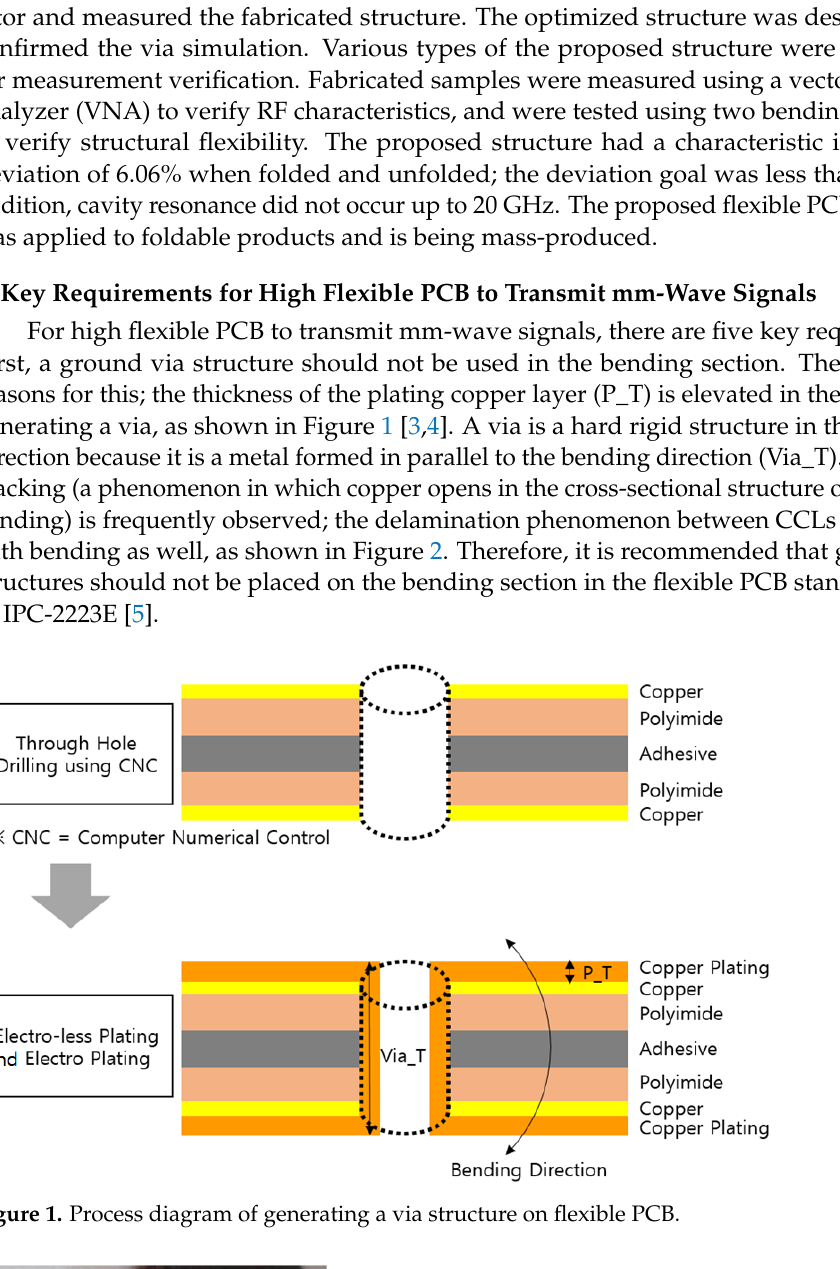
( c ) Figure 4. Return current densities of outer copper. ( a ) Current density without outer copper crack; ( b ) Current density with 1 um outer copper crack and an attached anisotropic conductive adhesive; and ( c ) Current density with 1 um outer copper crack and an attached isotropic conductive adhesive. Fourth, the impedance deviation before and after bending should be less than 10%. Figure 5 presents a conceptual diagram of signal transmission and reflection in the case of impedance discontinuity. The value of Z 0 is 50 ohm, which is mm-wave RF target imped- ance. As the impedance of the bending section, Z l , deviated from 50 ohm, the reflected wave (Γ) increased , as in Equation (1). An increase in the reflected wave indicated that the signal was not transmitted well. [6,7]